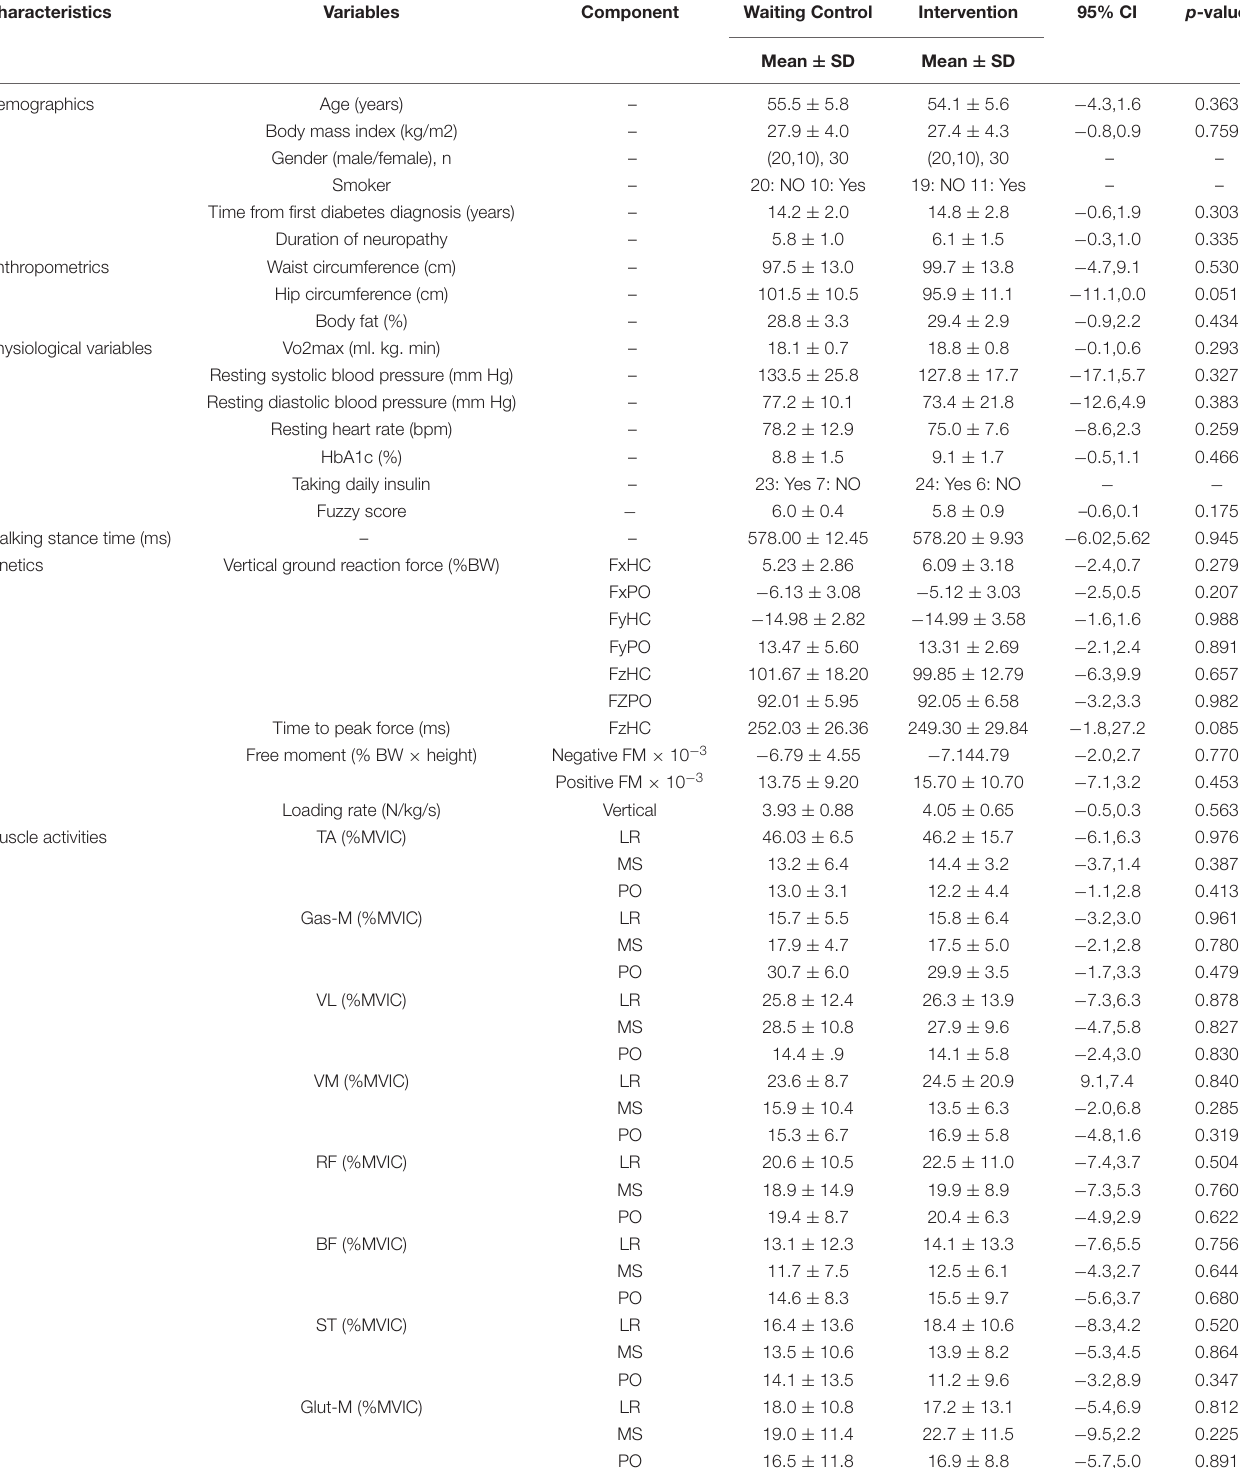
TABLE 3 | Group specific baseline data for demographic, anthropometric, physiological, and biomechanical (kinetics, muscle activity) data.